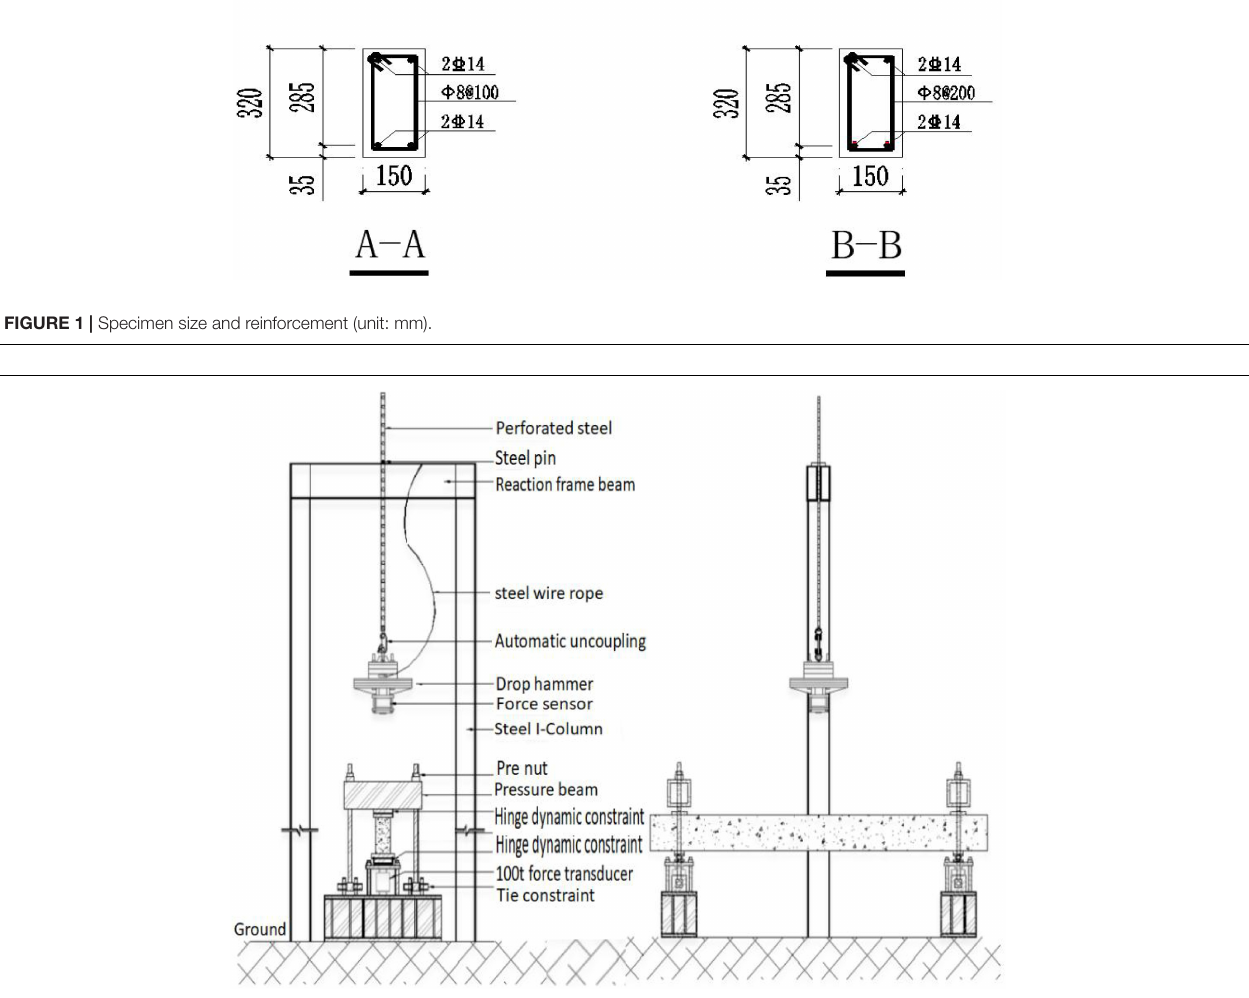
FIGURE 2 | Impact test